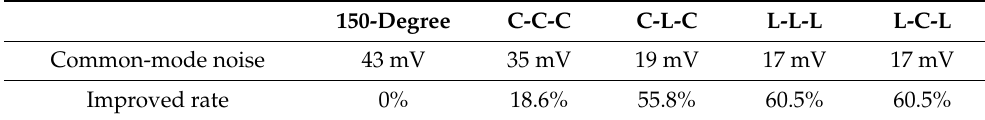
Table 5. The values of the measured eye diagram.